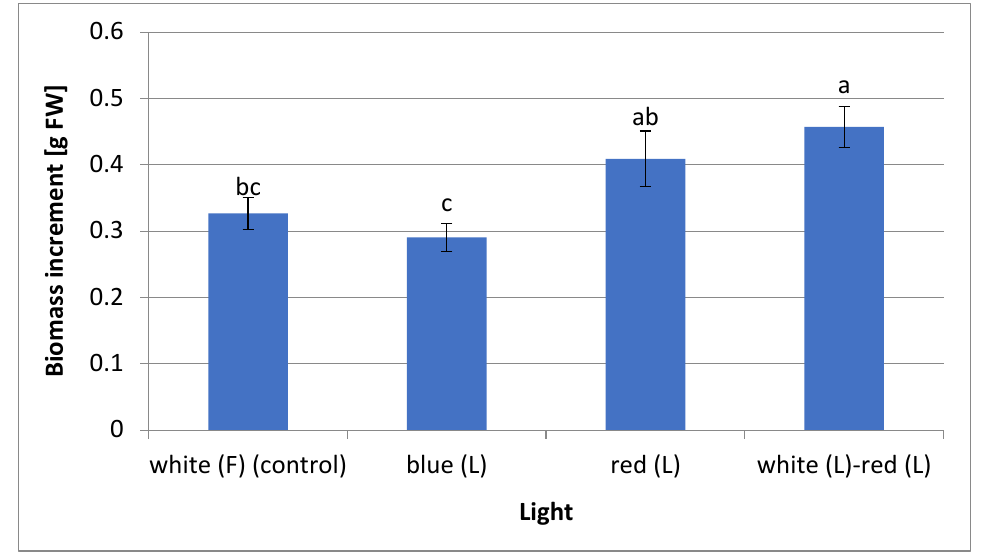
Figure 2. Biomass increments of L. aestivum plant cultures depending on the applied lighting conditions. Values are expressed as mean ± SD ( n = 10). Different letters indicate a significant difference at p < 0.05 according to ANOVA and Duncan’s tests. F: fluorescence, L: LED light, FW: fresh weight.